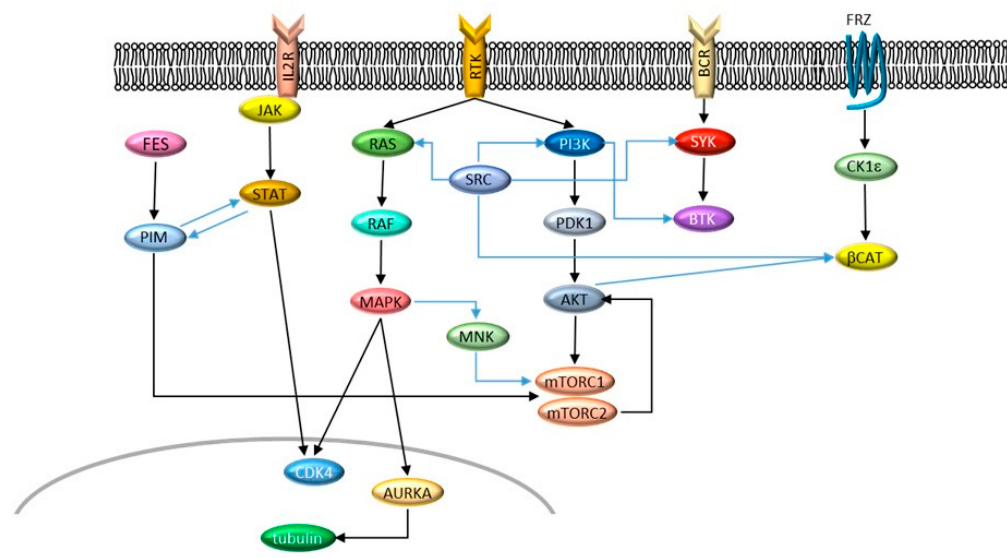
Figure 1. Signaling networks described in this review. Cross-talks are indicated by blue arrows.